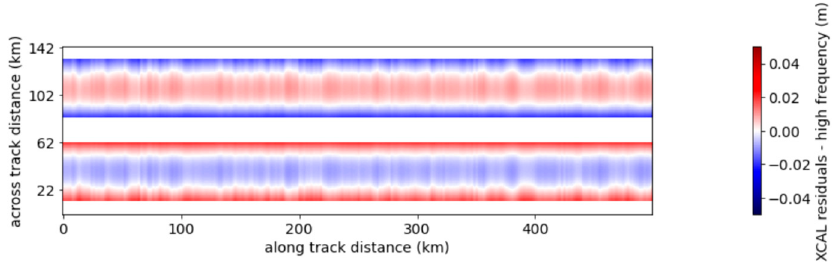
Figure 13. Example of high-frequency XCal residuals. This fi eld is added to the KaRIn noise.